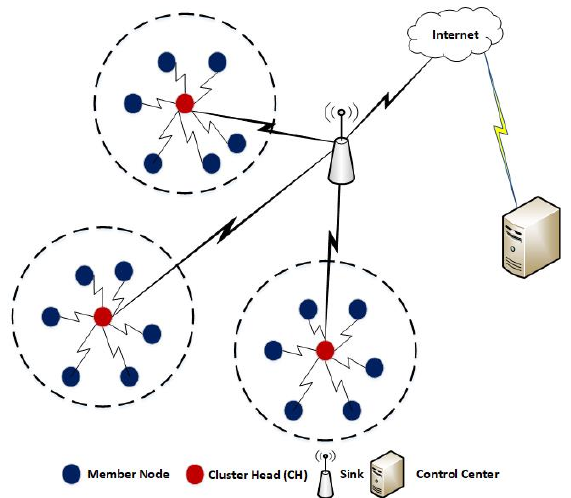
Figure 1. Clustering in Wireless Sensor Networks